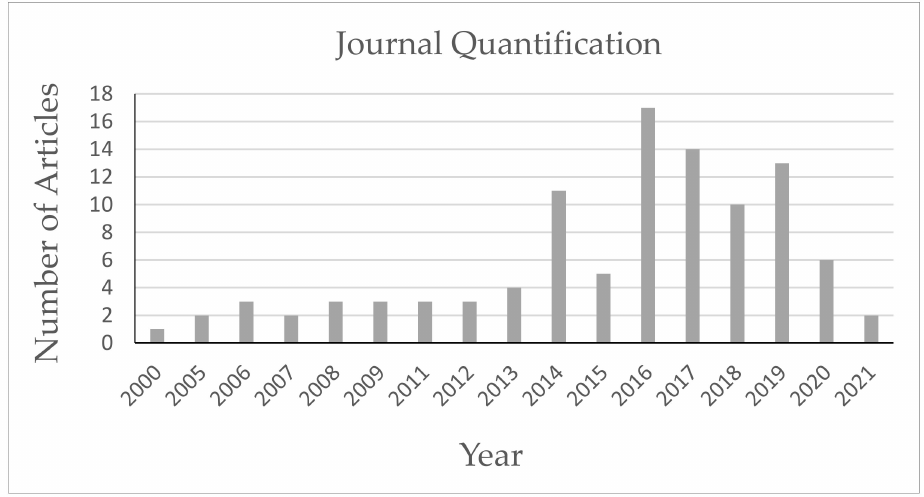
Figure 1. Quantification of journals in this